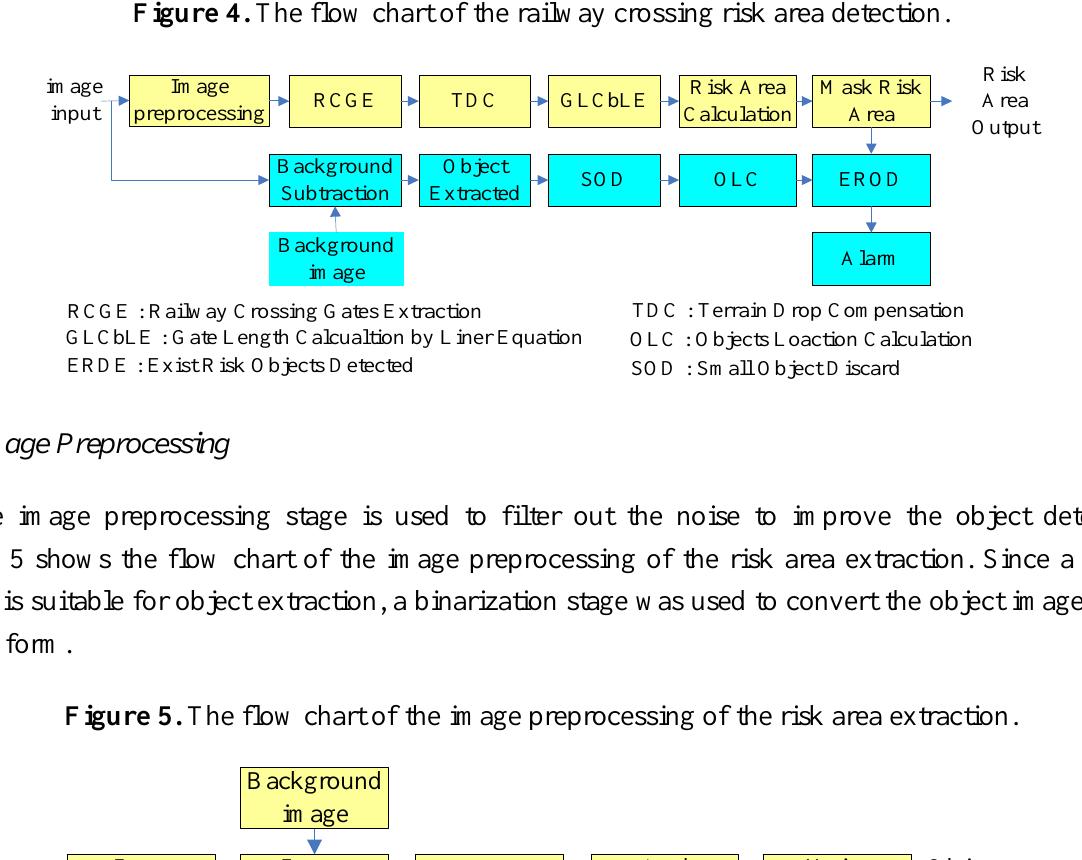
Figure 4. The flow chart of the railway crossing risk area detection.